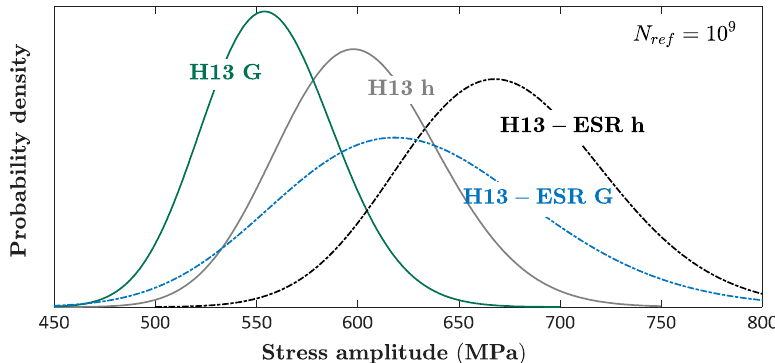
Figure 6. Corrected VHCF strength and probability density function for the tested specimens.